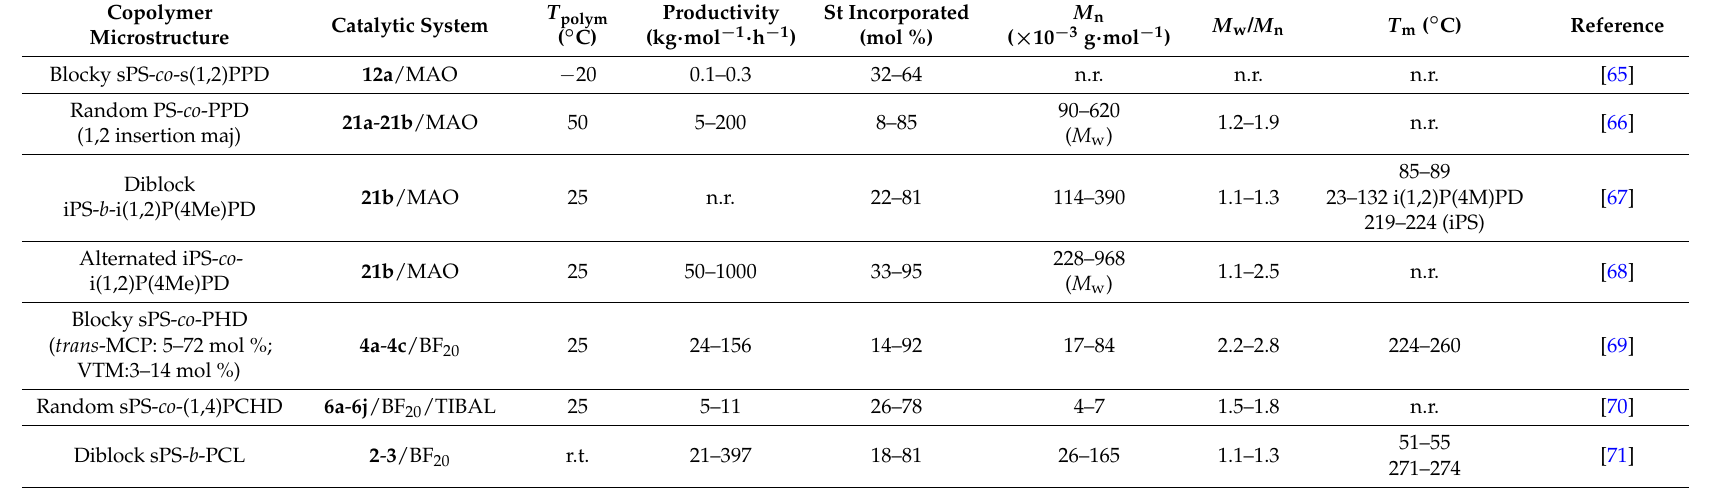
Table 4. Stereoregular copolymerizations of styrene with different dienes or caprolactone: catalytic system and polymer